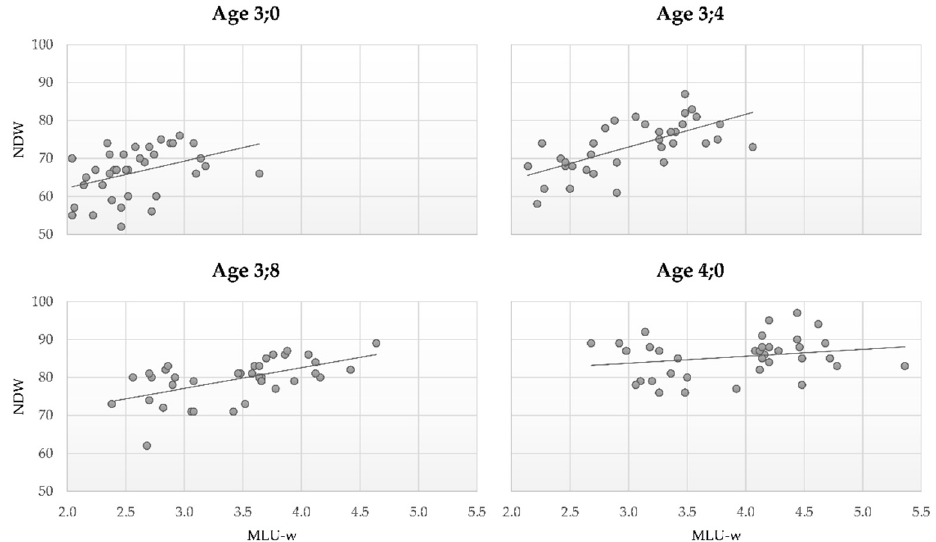
Figure 2. Scatterplots for the correlation between MLU-w and NDW at each age point (each presented in a different panel).